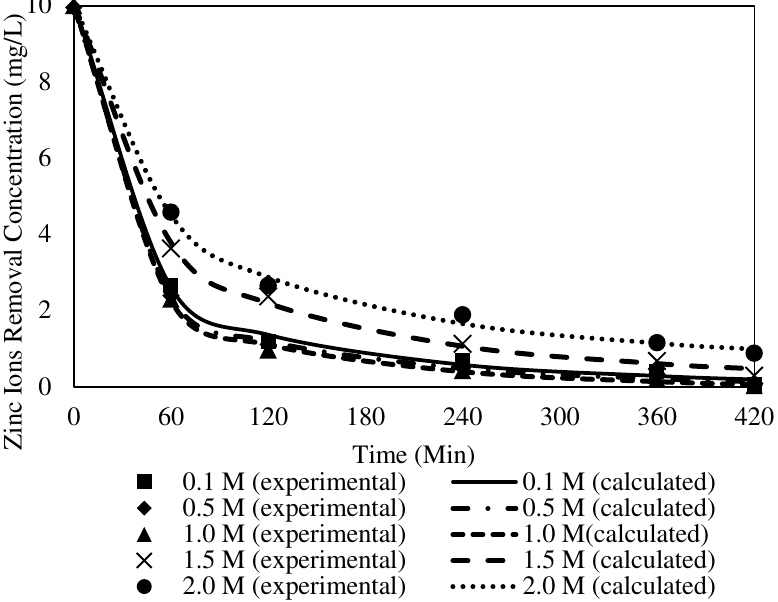
Figure 19. Fitting of the experimental data to the PSO model describing Zn 2+ removal with the W3 membrane over time at different receiving agent concentrations.